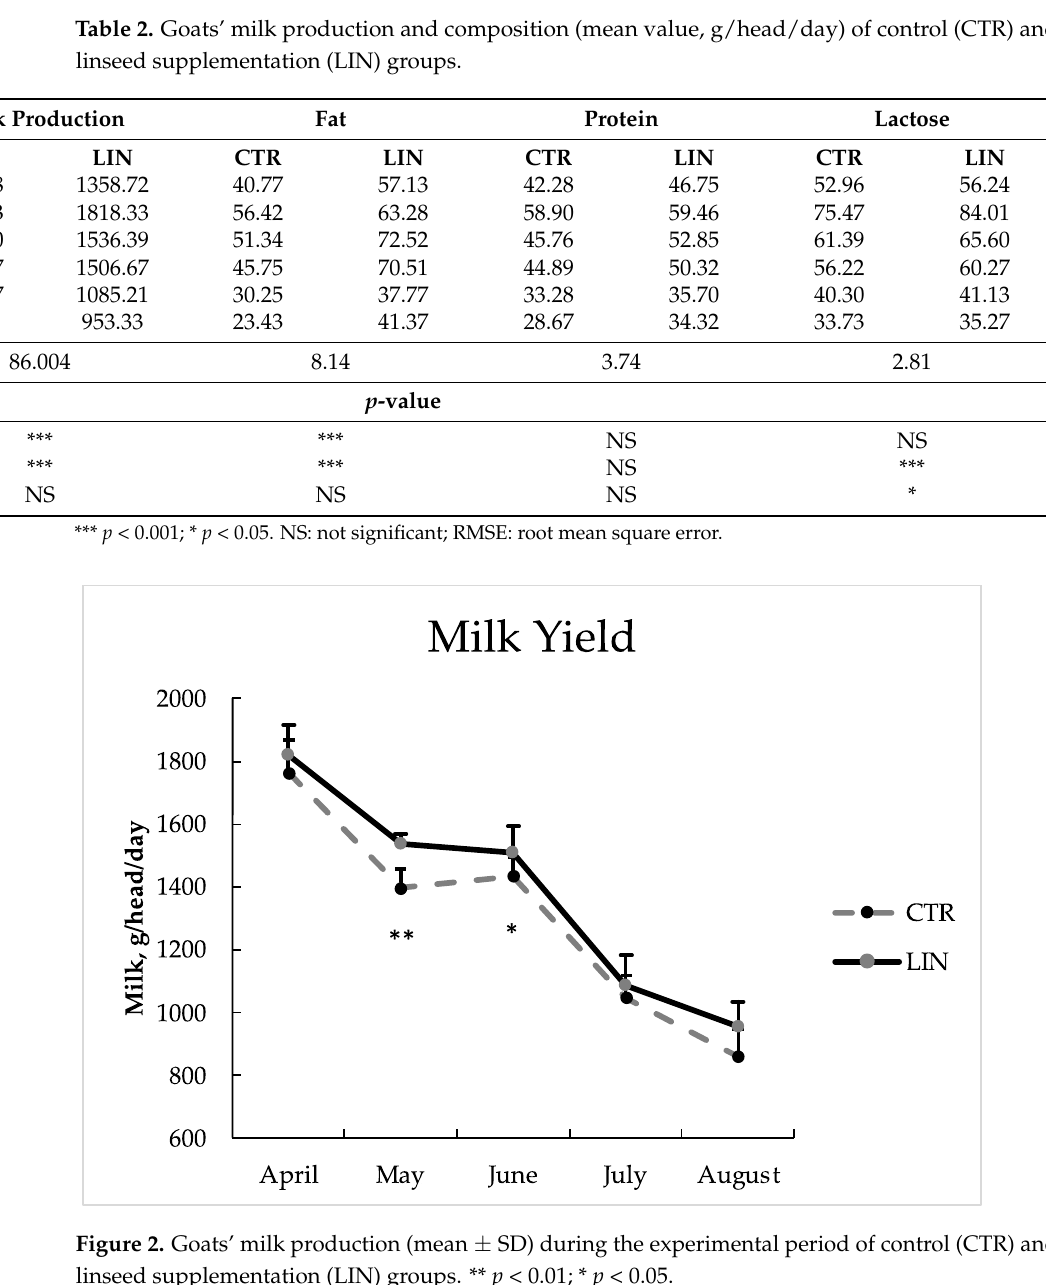
Table 2. Goats’ milk production and composition (mean value, g/head/day) of control (CTR) and linseed supplementation (LIN) groups.